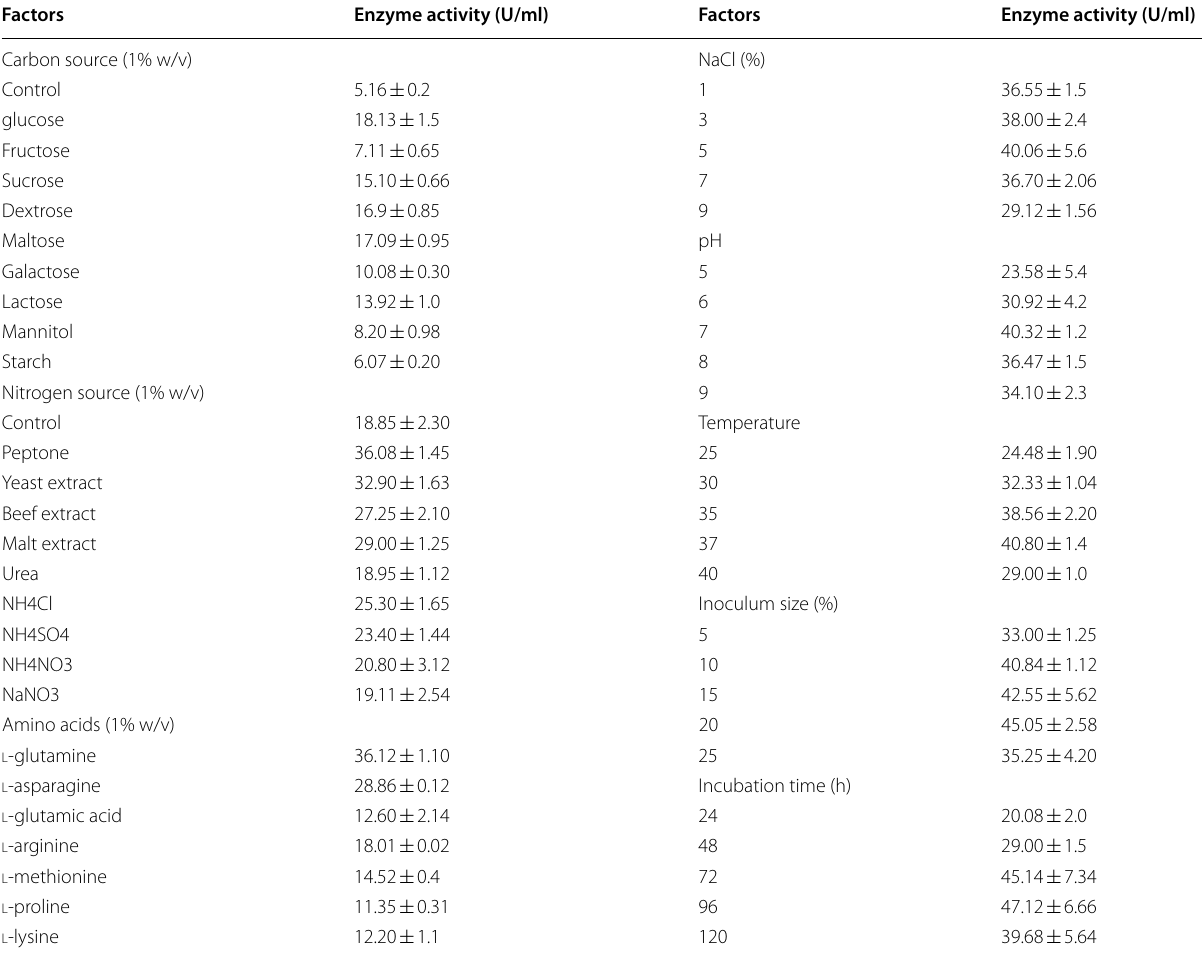
Table 1 Effect of various nutritional and environmental factors on l -glutaminase production by Bacillus sp. DV2-37. Data represent the mean of 3 different readings standard ±